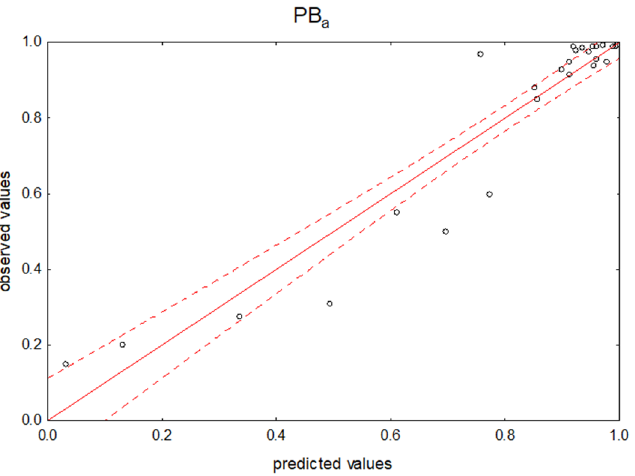
Figure A1. Predicted vs. observed values for MLR model using NP TLC retention data. Dependent variable: PB a .